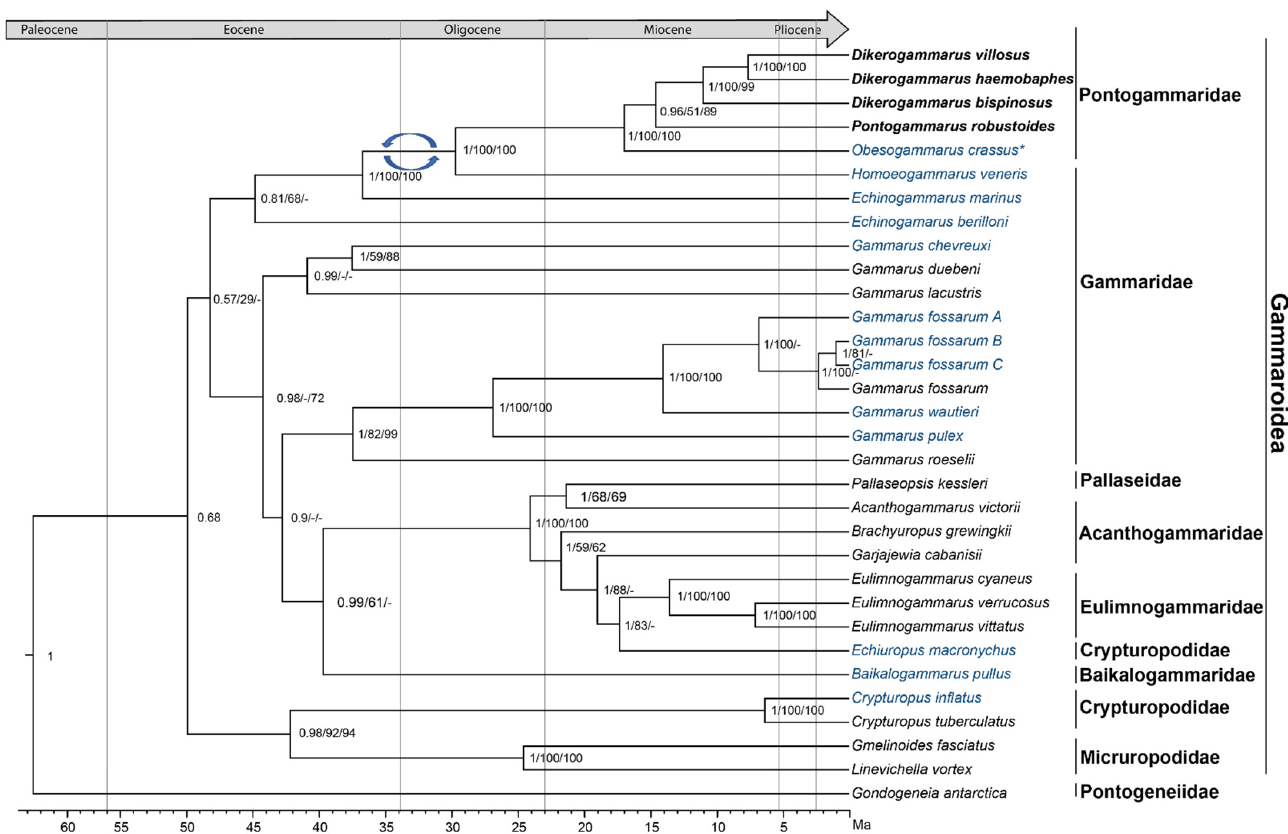
Figure 3. A Bayesian phylogenetic maximum clade credibility chronogram of the Gammaroidea, based on available mitogenomic and mitochondrial transcriptome data. The sources of sequences used are indicated in Table S1. Numbers next to branches indicate support: Bayesian posterior probabilities from chronogram/bootstrap values from maximum likelihood (ML) phylogeny on full data/bootstrap value for ML based on proteins (see Materials and Methods). Arrows indicate a putative tRNA rearrangement. On the right, the vertical lines indicate the families and the superfamily. Species names in bold sequences indicate assembled de novo from own data, names in blue indicate newly reconstructed from third party transcriptomic data. *indicates Pandorites podoceroides (SRR3467097), which was revealed to be Obesogammarus crassus